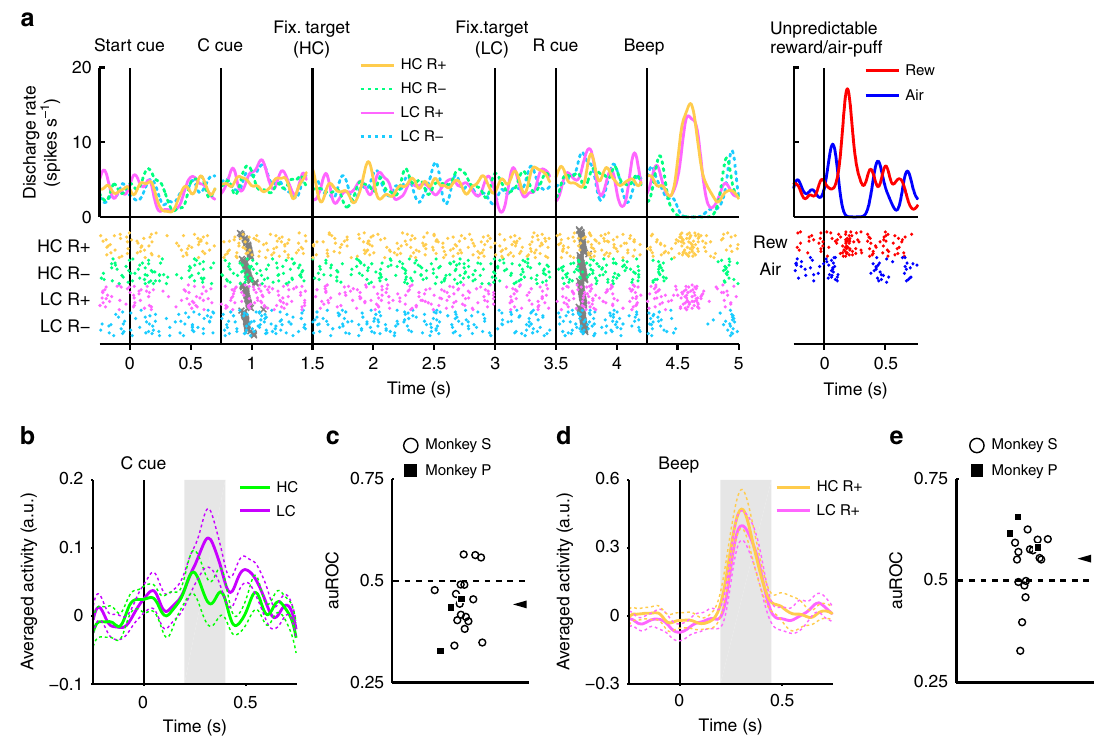
Fig. 6 Dopamine neuron response to the reward delivery. a Representative dopamine neuron activity in the HLC uncertain task. Each color represents the conditions (yellow: HC + , green: HC − , pink: LC + , cyan: LC − ). The timings of the saccade onset are indicated by gray crosses. The responses of this dopamine neuron to the unpredictable reward and air-puff are also depicted in the right panel (red: unpredictable reward, blue: unpredictable air-puff). b Population-averaged activity of the dopamine neurons recorded from monkey S to the condition cues. Green and purple colors indicate activity in the high-cost and low-cost trials, respectively. The solid lines and the dashed lines represent mean and SEM, respectively. Gray-colored area indicates the time window to calculate the fi ring rate as the response to the condition cues. c The distribution of the auROCs to quantify the effect of the predicted cost on the neuronal response to the cost cues. Filled squares indicate the data from the monkey P ( n = 3) and open circles indicate the data from the monkey S ( n = 16). The arrowhead indicates the median of the auROC (0.44). d Population-averaged activity of the dopamine neurons recorded from the monkey S to the reward delivery. Yellow and pink colors indicate activity in the high-cost and low-cost trials, respectively. Gray-colored area indicates the time window to calculate the fi ring rate as the response to the reward delivery. e The distribution of the auROCs to quantify the effect of the paid cost on the neuronal response to the reward delivery. The arrowhead indicates the median of the auROC